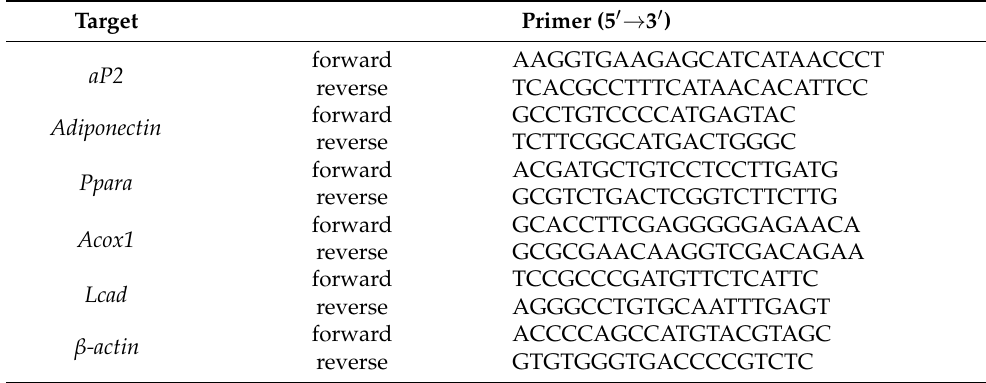
Table 1. The primer sequences used for qRT-PCR.